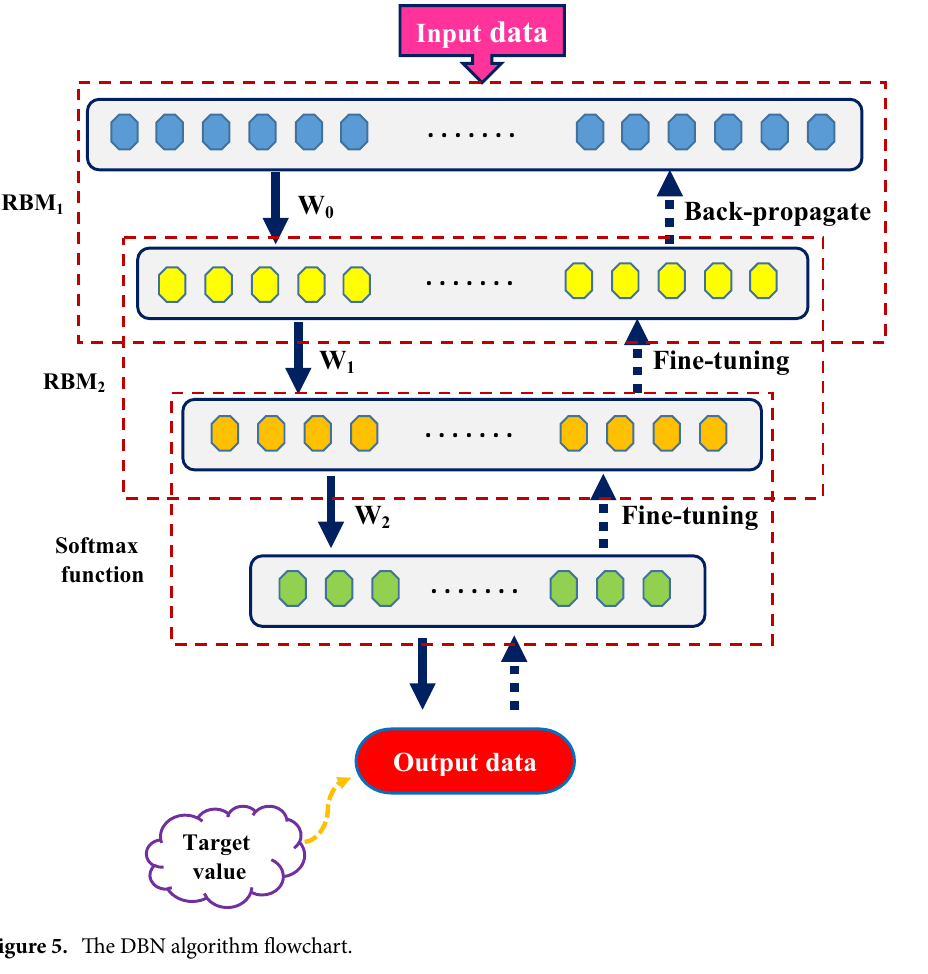
Figure 5. The DBN algorithm flowchart.